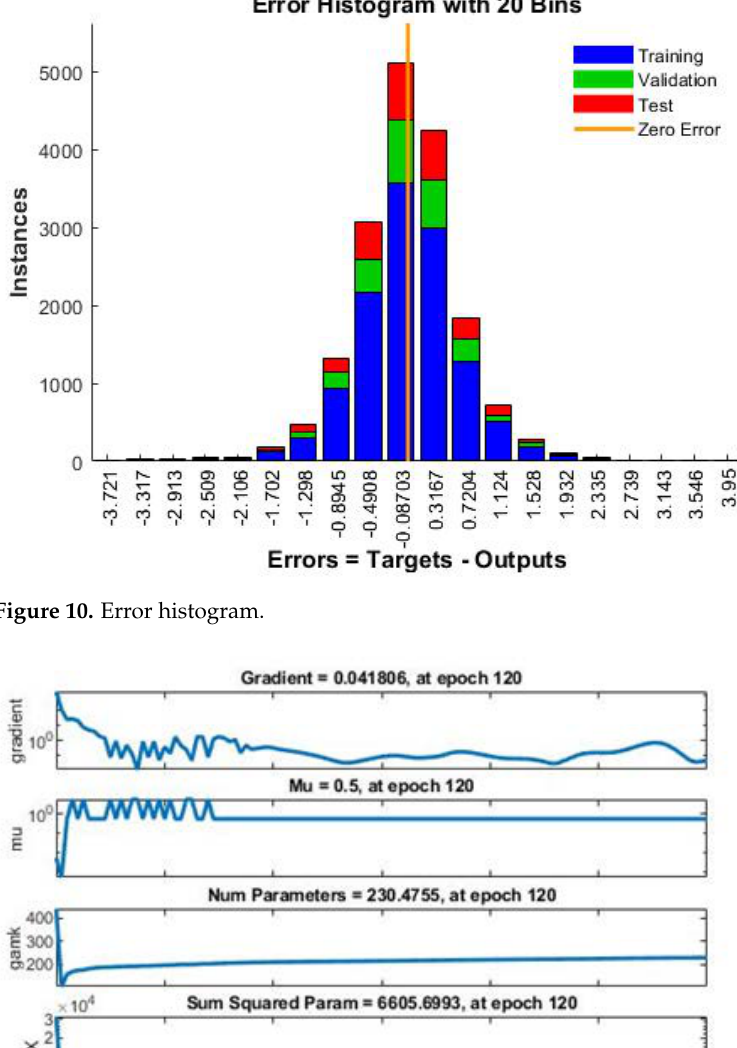
Figure 9. Regression charts received from the Neural Network Training tool.